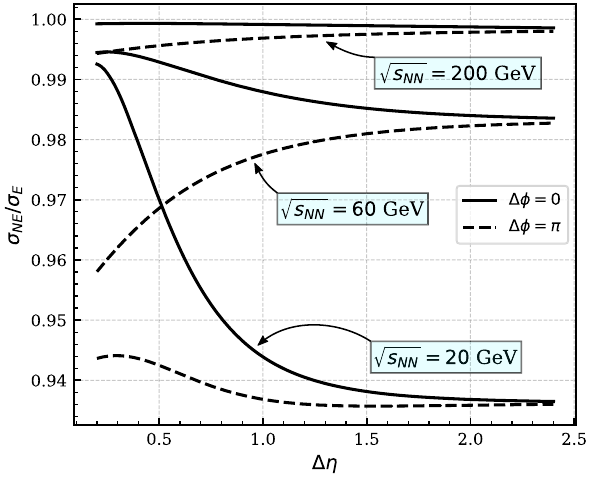
Fig. 5 Azimuthal harmonics computed using the prescription of Eq. (20). The parameters used for this plot are μ T = μ g = 0 . 4 GeV, μ = 0 . 2 GeV and η = η = 1 . 5. The dashed lines are the result P 1 2